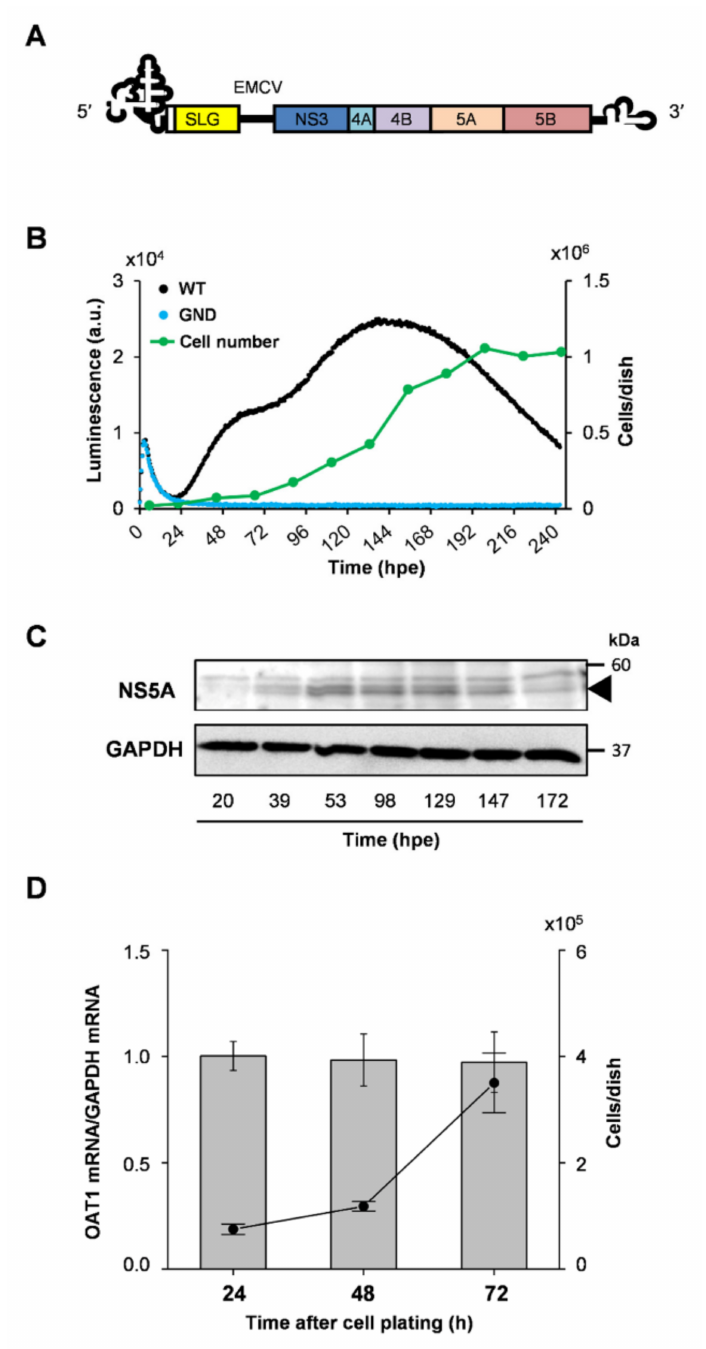
Figure 1. Development of real-time monitoring system of HCV RNA replication. ( A ) Schematic representation of HCV subgenomic replicon used in this study. The subgenomic replicon contains the 5 (cid:48) untranslated region of HCV, which directs the IRES-mediated translation of the green-emitting luciferase SLG gene. An encephalomyocarditis virus (EMCV)-IRES mediates translation of the